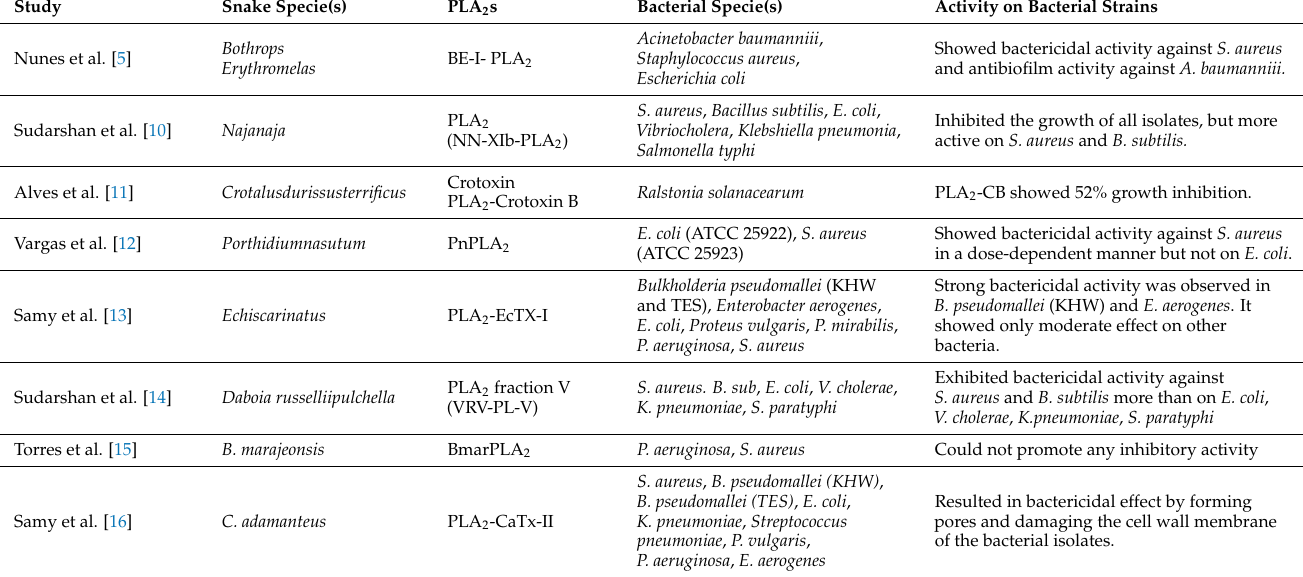
Table 1. Features of the analyzed